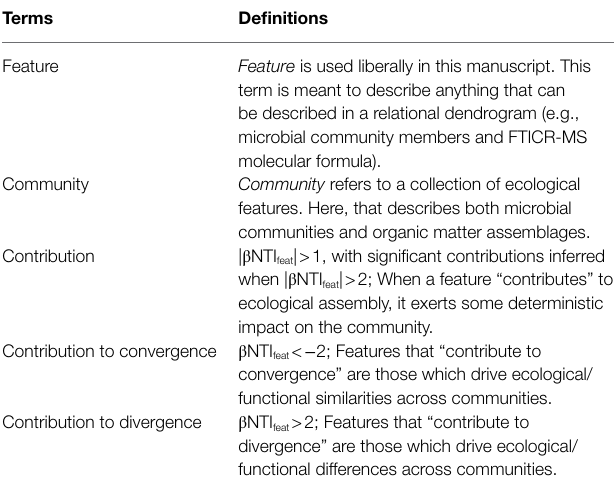
TABLE 1 | Table of terms used throughout the manuscript and their